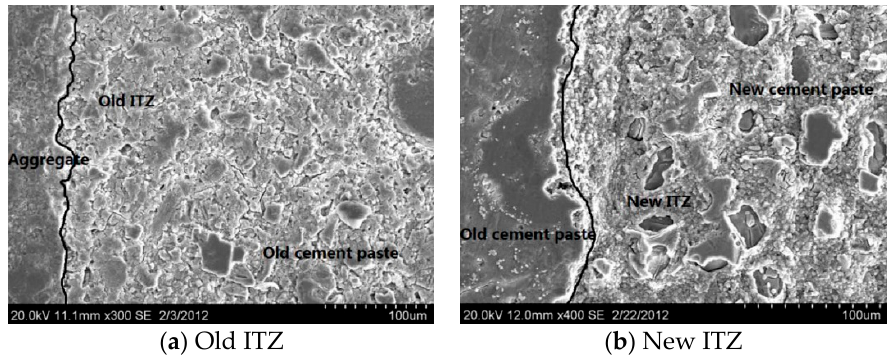
Figure 3. SEM images of ITZs. ( a ) Old ITZ ( b ) New ITZ.